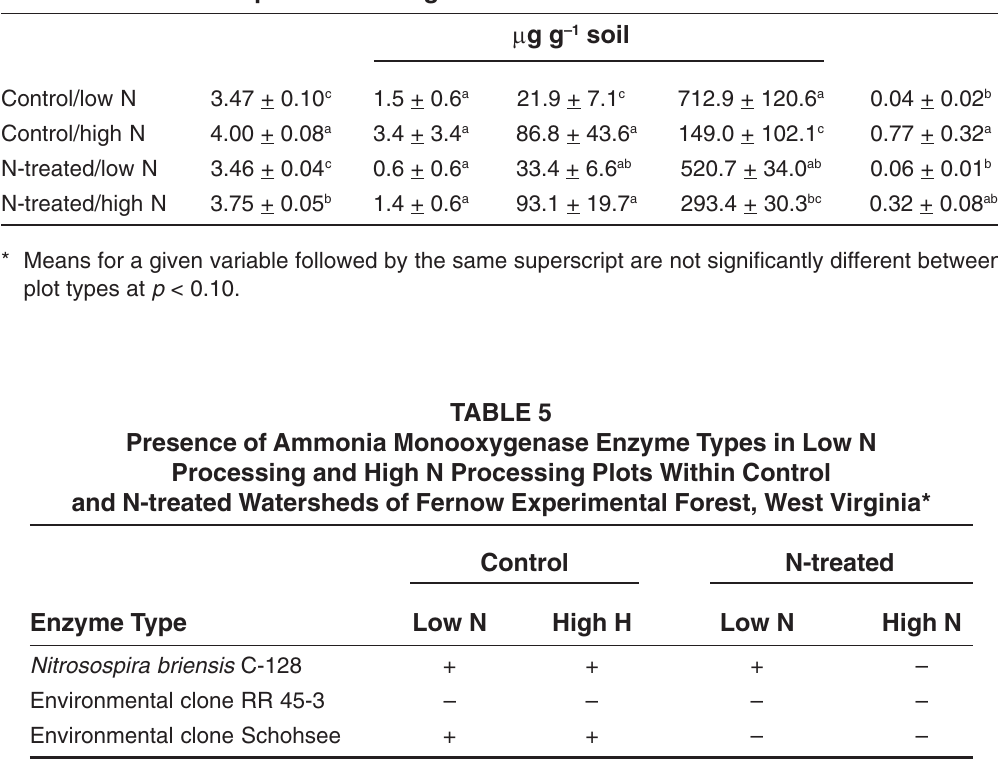
Microbial Community